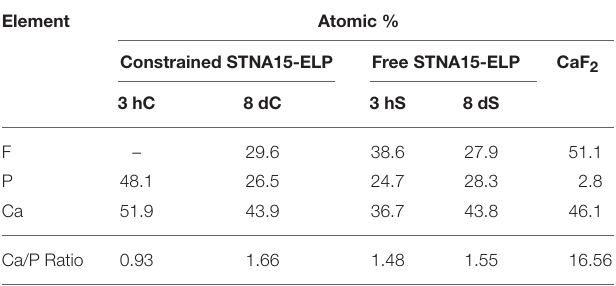
TABLE 3 | EDX data showing the atomic % of elements present in each sample.